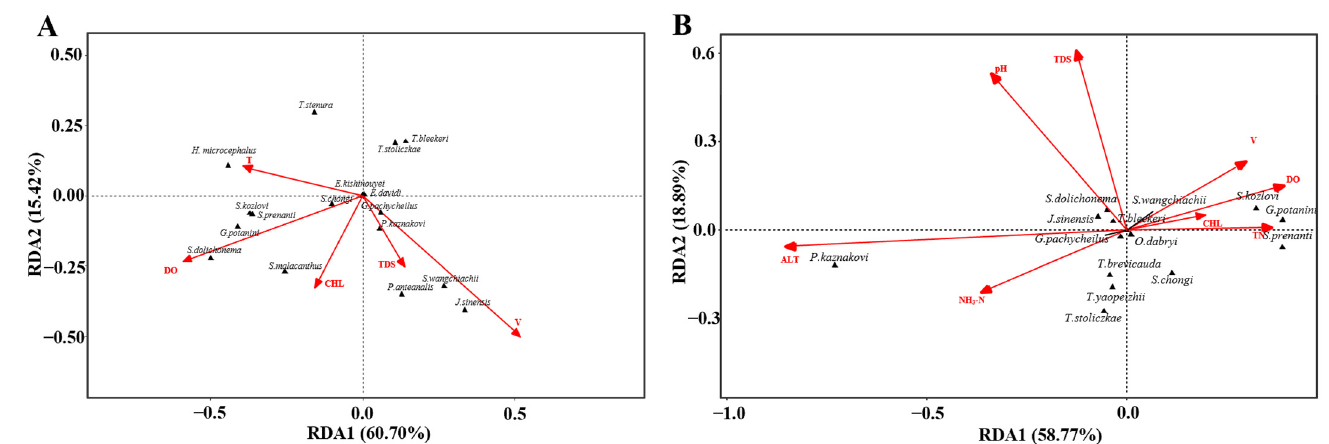
Figure 5. Redundancy analysis (RDA) of the relationship between fish distribution and environmental factors in the wet season ( A ) and dry season ( B ).